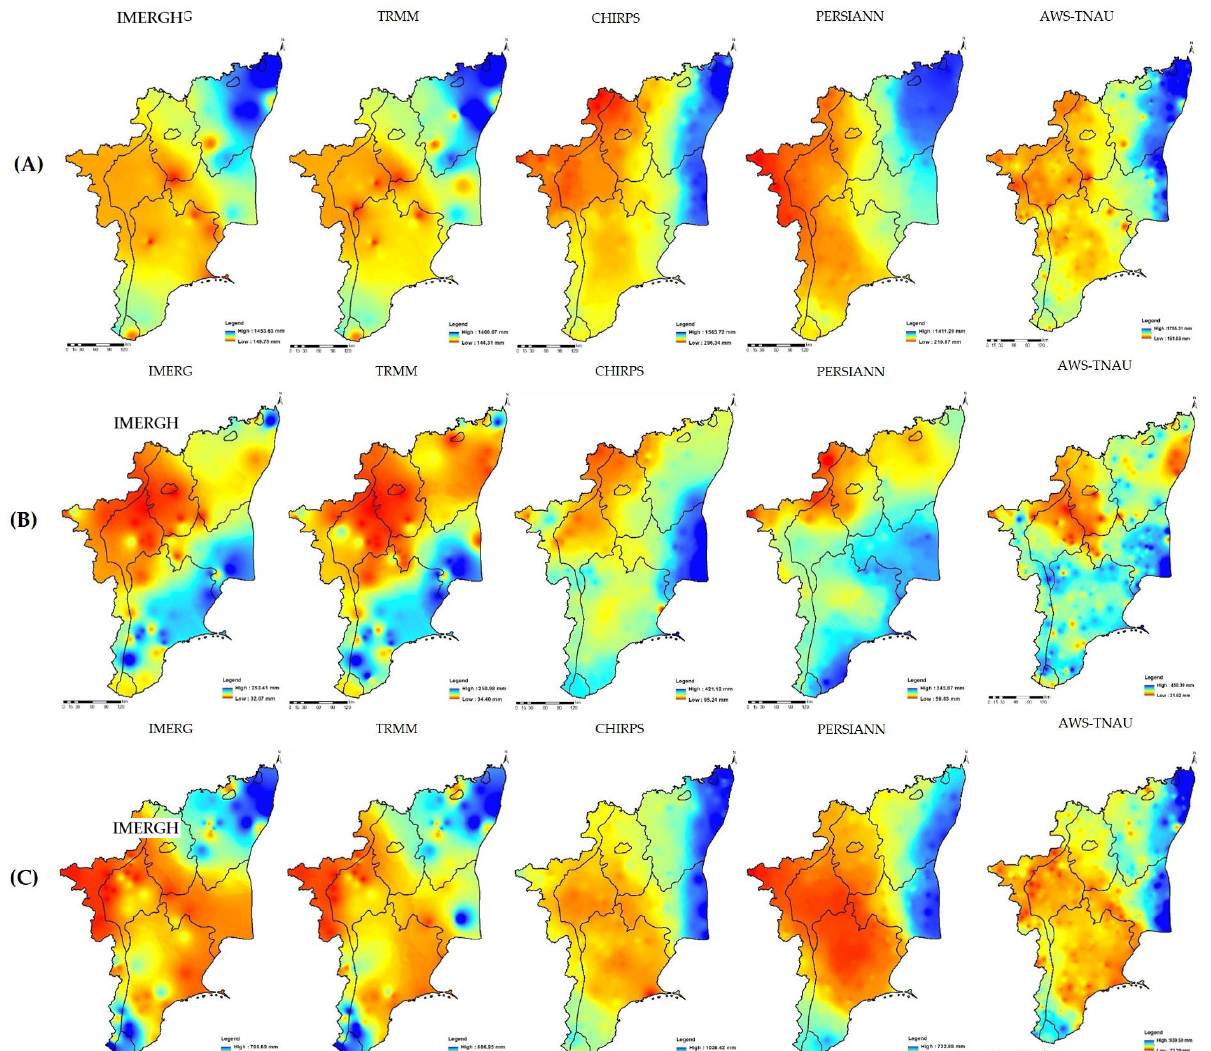
Figure 6. Spatial distribution of seasonal precipitation of high-resolution precipitation products during ( A ) 2015, ( B ) 2016, and ( C ) 2017 from interpolated gauge station at the spatial resolution of 0.25 degree.